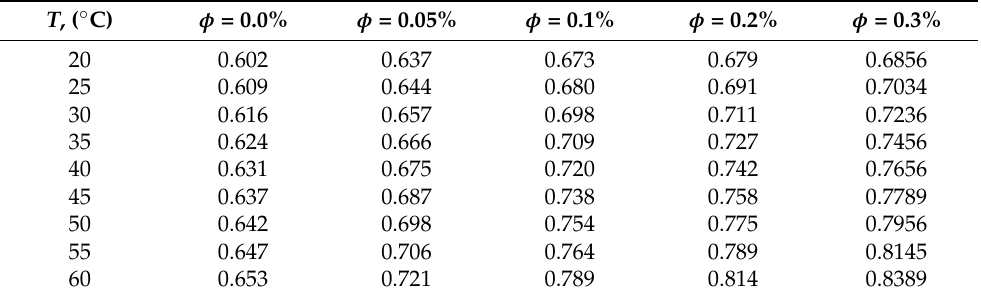
Table 2. Thermal conductivity of hybrid nanofluids.